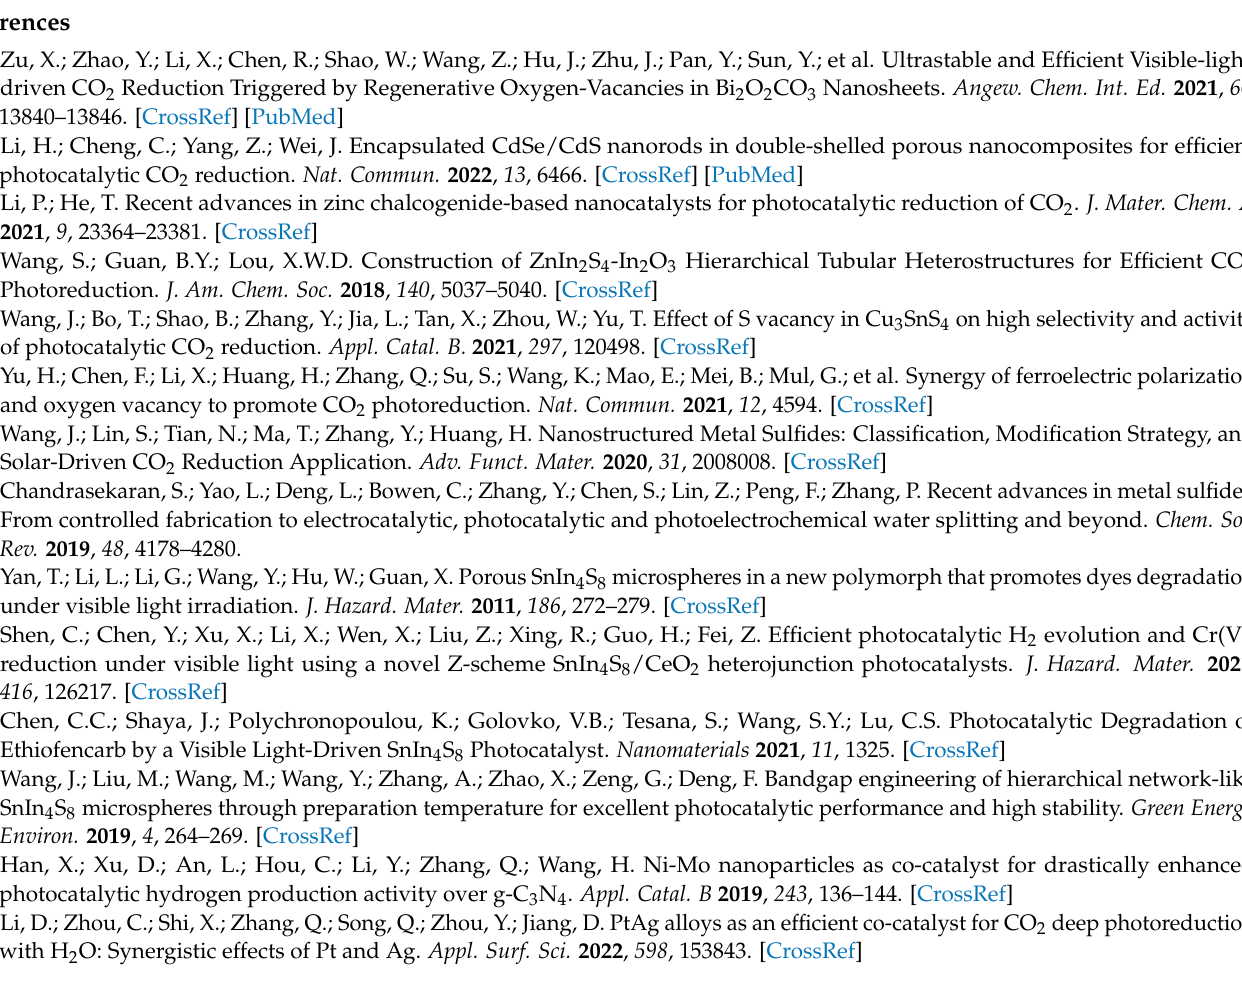
and after photocatalytic CO 2 reduction reaction; Figure S5: SEM image of Cu 10 Au 1 -SnIn 4 S 8 after photocatalytic CO 2 reduction reaction; Figure S6: Tauc plots of SnIn 4 S 8 ; Figure S7: Mott-Schottky plots of SnIn 4 S 8 ; Table S1. Comparison of the CO 2 photoreduction performance of Cu 10 Au 1 -SnIn 4 S